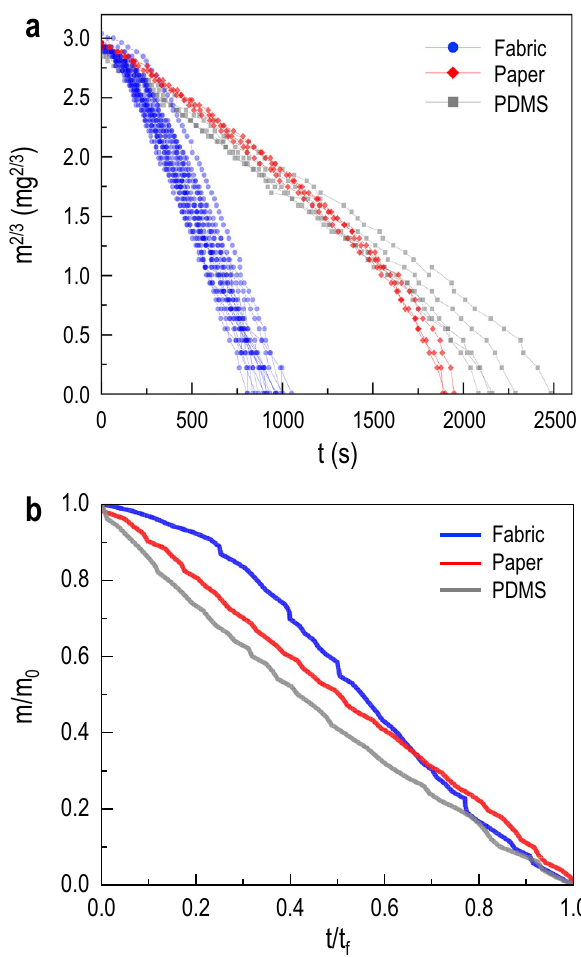
Figure 6. Droplet evaporation dynamics for porous and non-porous substrates. (a) The linearity in water 2 / 3 mass m versus time t indicates the diffusion-limited evaporation of water vapor, which governs most of the evaporation times. A deviation from this linearity indicates how substrate properties affect the evaporation dynamics of a sessile droplet. The fabric substrate displays the highest evaporation rate. (b) Distinct evaporation behavior is depicted by comparing the different substrates. Here, the mass m is normalized to its initial value m 0 and the time t is normalized to the final evaporation time t f